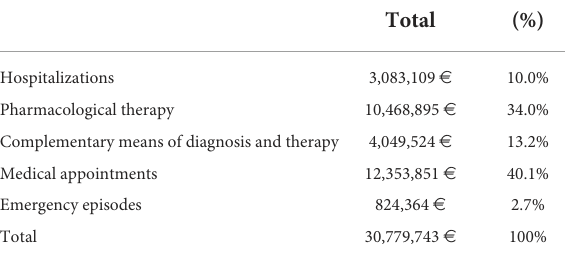
TABLE 8 Direct and Indirect costs ( e ) attributable to TRD and